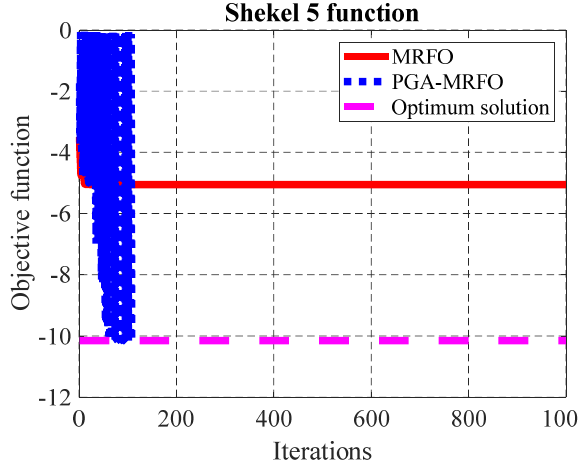
Figure 9. Converges curves for F 21 .